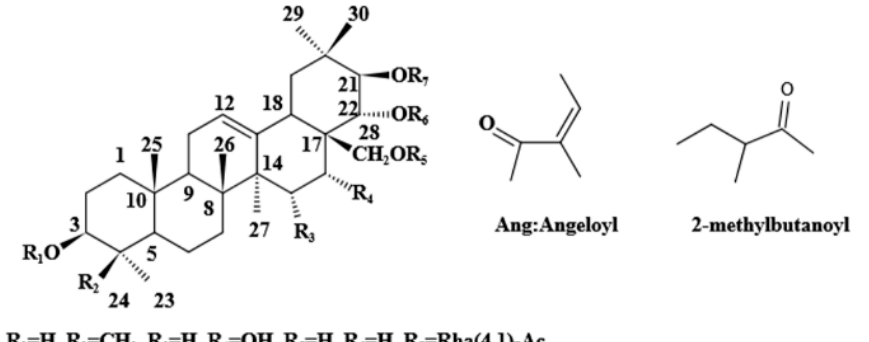
Figure 6. Total ion chromatogram (TIC) 200–2000 m/z of the TPMBr − La − extract saponins of X. sor- bifolia .